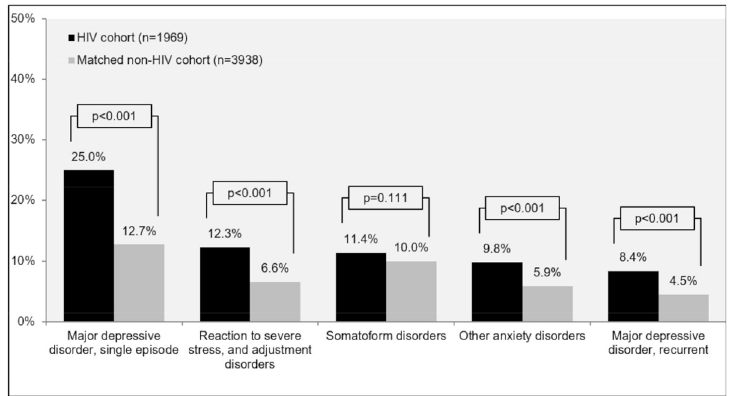
Table 3. Healthcare costs by healthcare sector in PLHIV and a matched non-HIV cohort over the previous 12 months. Costs HIV cohort